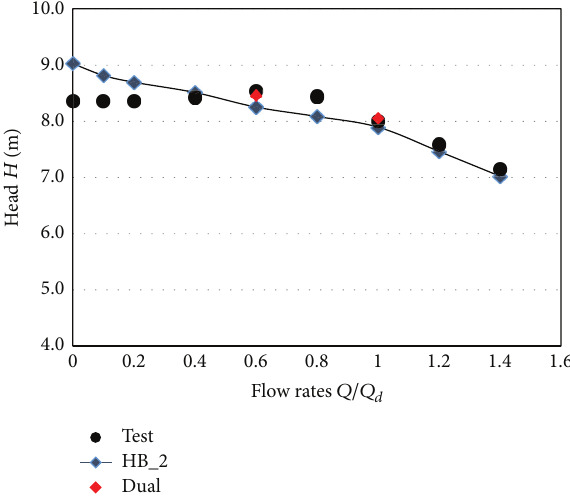
Figure 7: The predicted head compared with the test